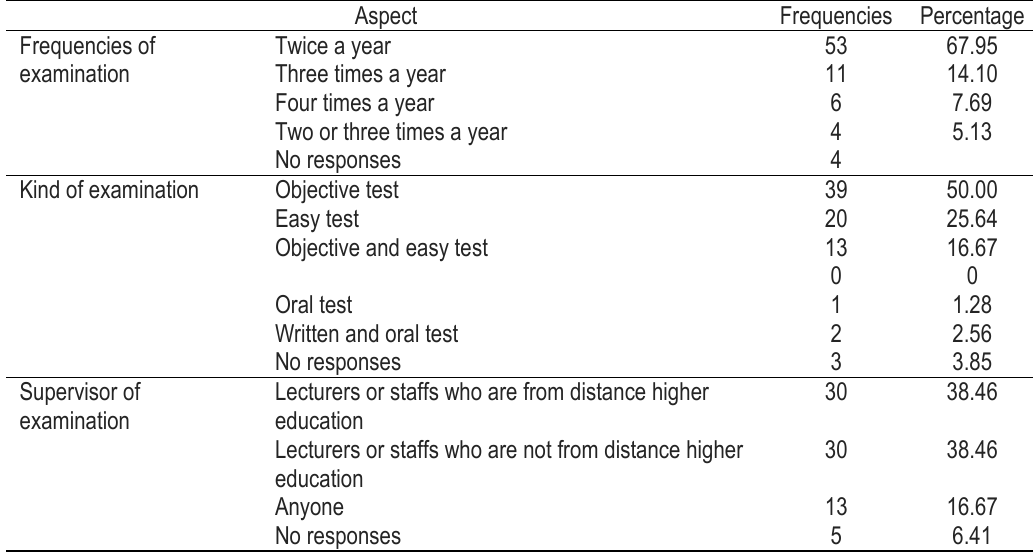
Table 8: Respondents’ idea about examination service.